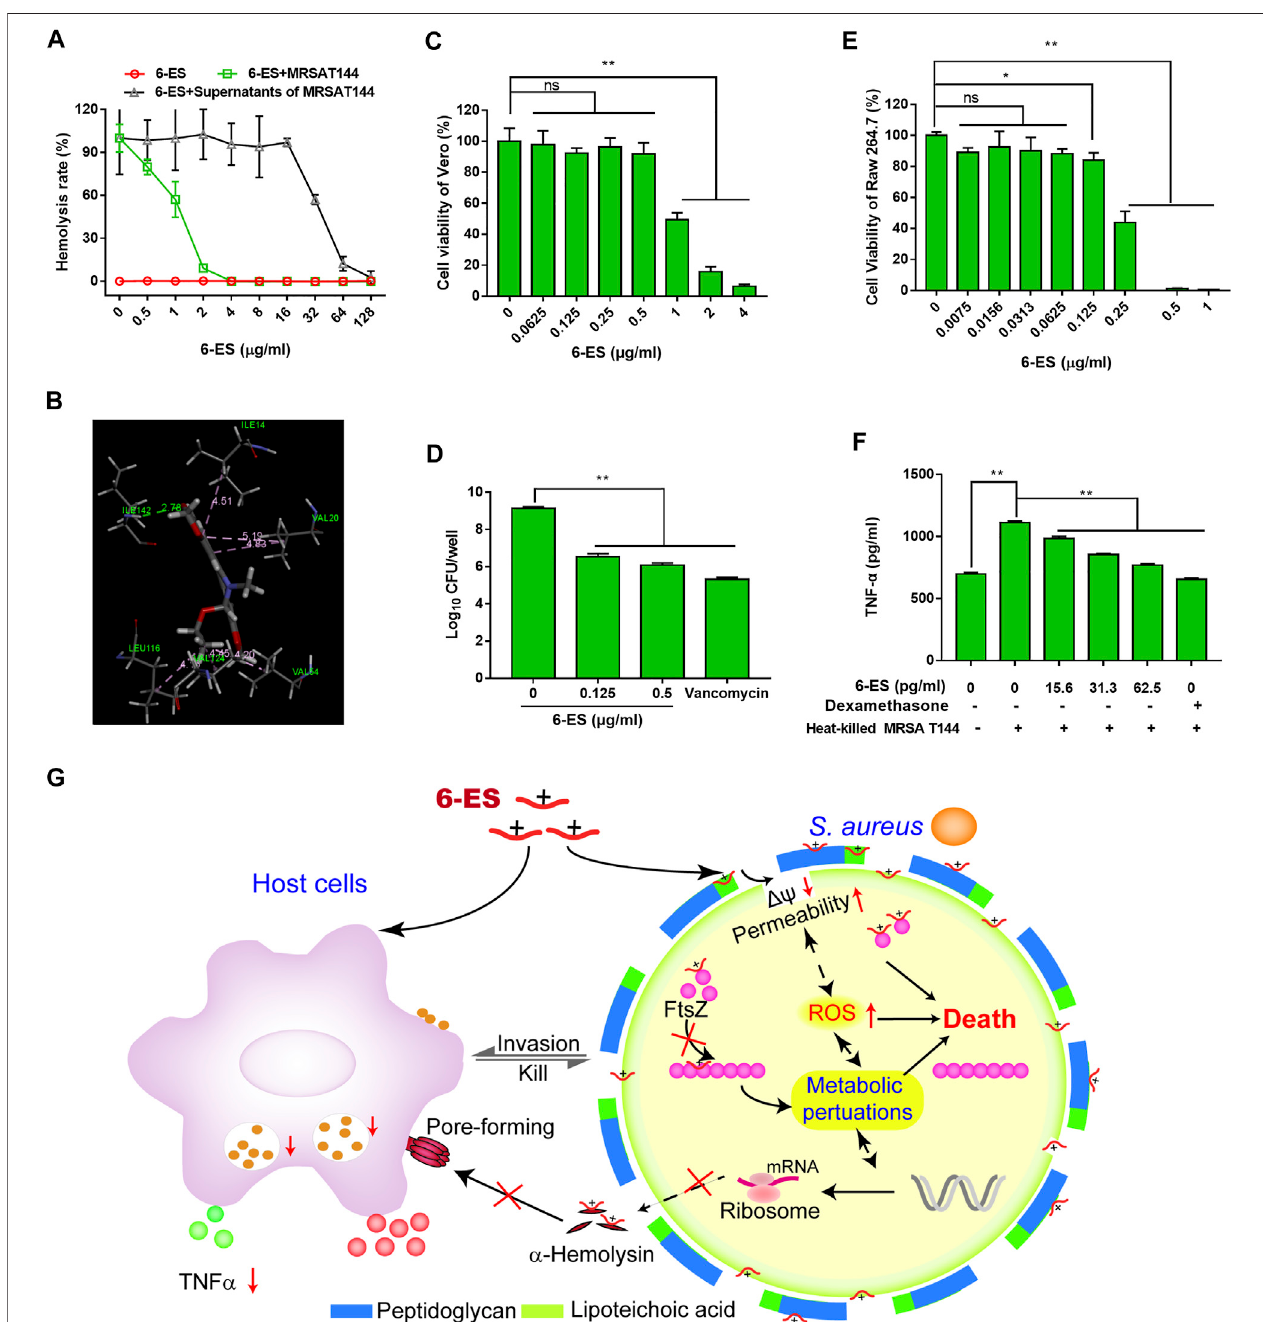
FIGURE 4 | 6-ES suppressed the virulence of S. aureus and modulated the host immune response. (A) MRSA T144 cells were cultured with different concentrations of 6-ES or DMSO for 12 h, and the supernatants were harvested to test the hemolytic activities toward sheep red blood cells. The supernatants from DMSO-treated MRSA T144 were used to evaluate the toxin neutralization effect of 6-ES against α -hemolysin. (B) Molecular docking of 6-ES with α -hemolysin. (C, E) VeroorRAW264.7cellsweretreatedwithdifferentconcentrationsof6-ESfor24 h,andthen,thecellviabilitywasmeasuredwiththeWST-1method. (D) Verocells were infected with MRSA T144 and then treated with 6-ES or vancomycin for 6 h. The intracellular bacterial number was measured by the plate method. (F) RAW264.7 cells were incubated with 6-ES for 1 h and then stimulated with heat-killed MRSA T144 for 24 h. After incubation, the supernatants were harvested to detect the level of TNF α byELISA. (G) Multiplemechanismsfor6-ESactivityagainstMRSA.6-EScollapsedthemembranepotential,increasedmembranepermeability,andpromotedthe accumulation of ROS in S. aureus , possibly by targeting the membrane and FtsZ, which led to metabolic disorders and cell death of S. aureus . Moreover, 6-ES modulated metabolic processes, such as cell division and virulence factors. 6-ES directly suppressed the hemolytic activity induced by α -hemolysin. In addition, 6-ES modulated the host in fl ammatory response caused by S. aureus . Multiple mechanisms of 6-ES supported 6-ES as a novel leading compound with antibacterial activity, antivirulence activity, and host immunomodulatory activity.